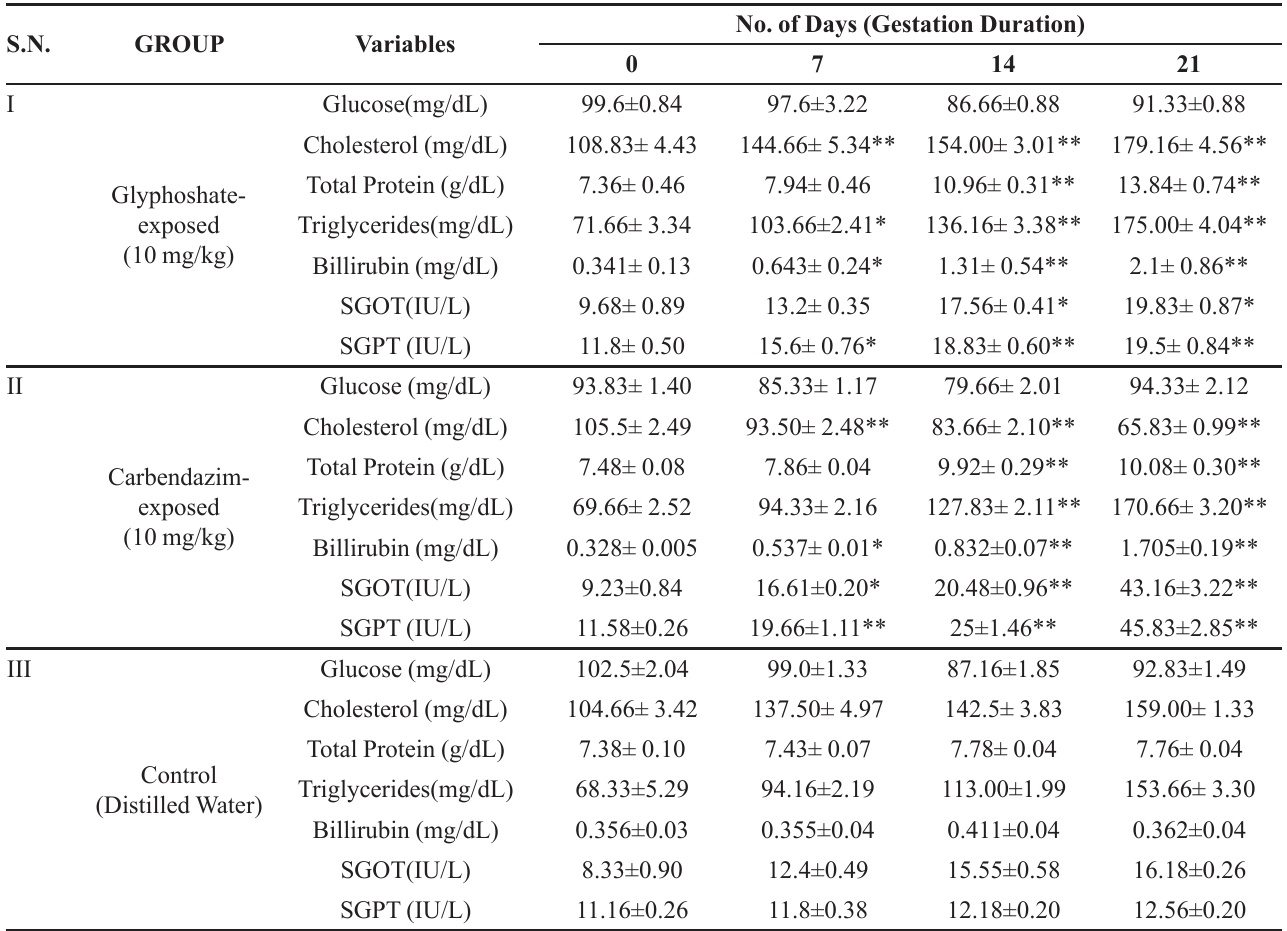
TABLE III - Serum biochemistry of pregnant female rats